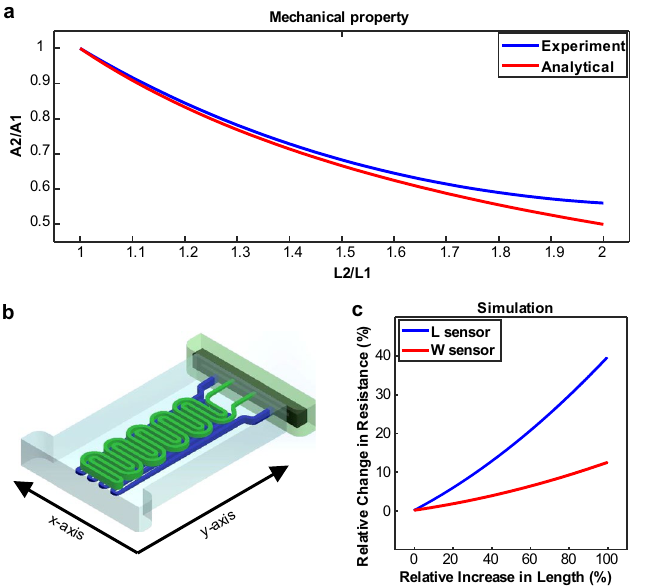
Figure 1. Sensor design (Type-2) and simulation results. ( a ) Comparison between analytical and simulation data of the mechanical properties, ( b ) the schematics of the sensor used in the simulations, ( c ) Simulated sensors’